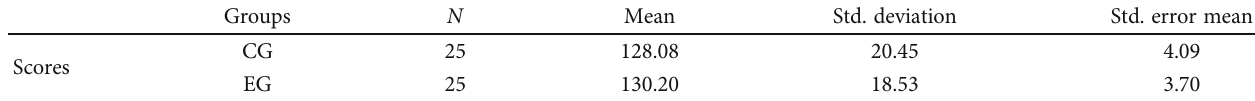
Table 6: Descriptive statistics of the motivation